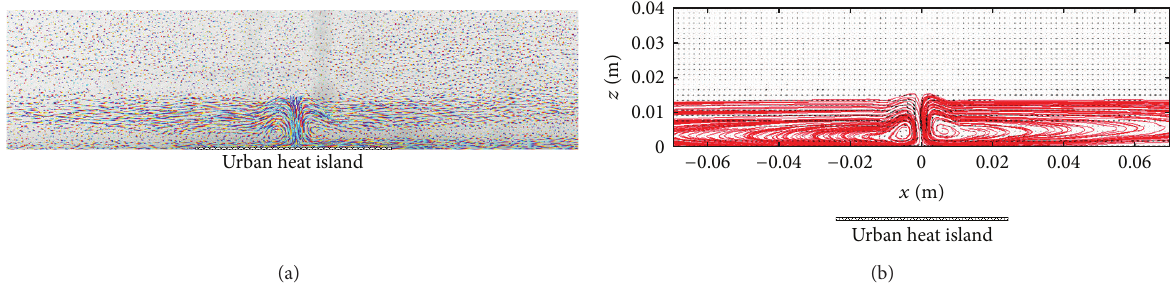
Figure 29: Nocturnal UHI: (a) particle trajectories reconstructed by FT; (b) time-averaged Eulerian velocity vectors and streamlines.